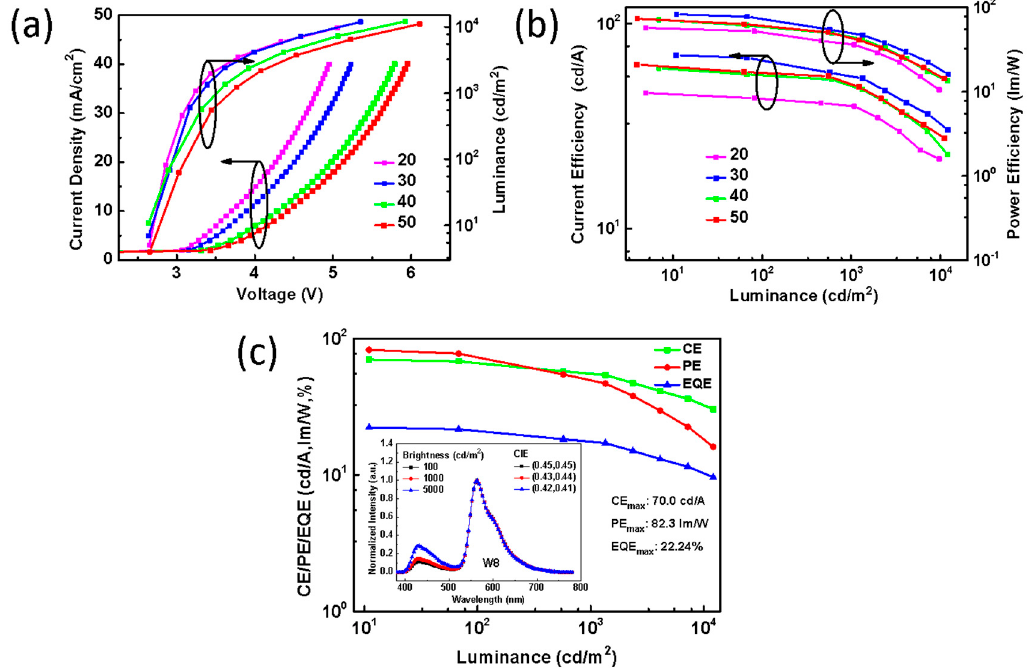
Figure 6. ( a ) Current density-voltage-luminance curves of four devices in this study. ( b ) Current efficiency ‐ luminance ‐ power efficiency characteristics with different ETL thicknesses. ( c ) CE, EQE, and PE of device W8. Inset: EL spectra and CIE of W8 at luminance of 100, 1000, and 5000 cd/m 2 . Table 2. Summary of voltages, power efficiency, current efficiency, EQE, CIE, and CCT for devices W5 to W8. a), b) Voltages were measured corresponding to the onset and 100 cd/m 2 . c) CIE and CCT were tested at 100 cd/m 2.